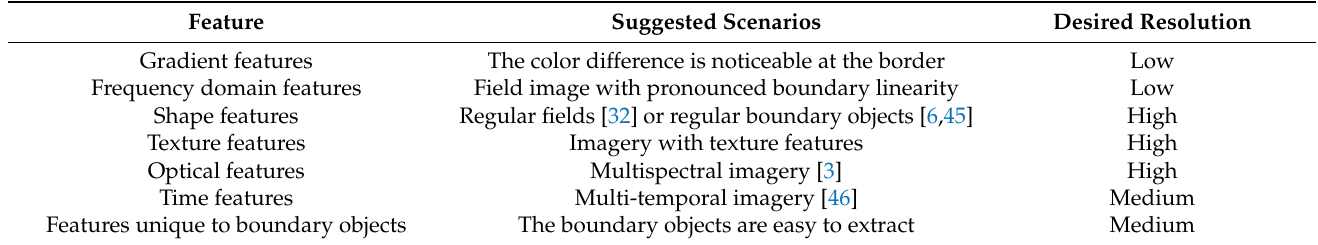
Table 13. Suggested scenarios and desired resolutions of